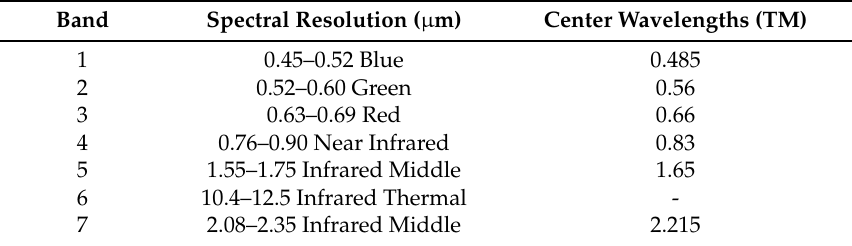
Table 2. Spectral resolution and center wavelengths